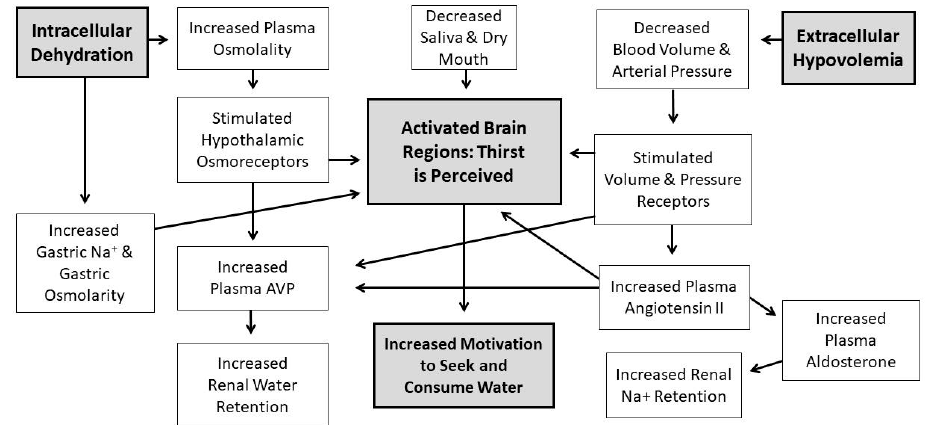
Figure 1. The thirst drive and motivation to seek/consume water are vital aspects of the homeostatic regulation of total body water volume and tonicity, in response to intracellular dehydration, increased plasma osmolality, decreased plasma volume, decreased blood pressure, and extracellular hypovolemia. Abbreviation: Na + , sodium.